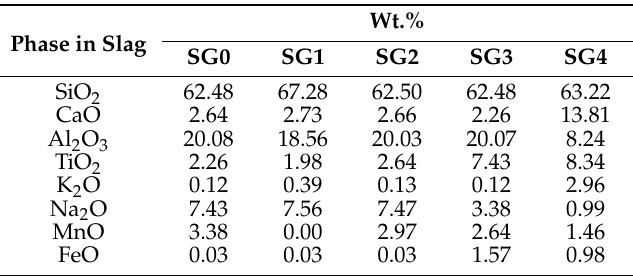
Table 5. Slag phase composition of the whole coal and various density fractions at slag-liquid formation onset temperature.